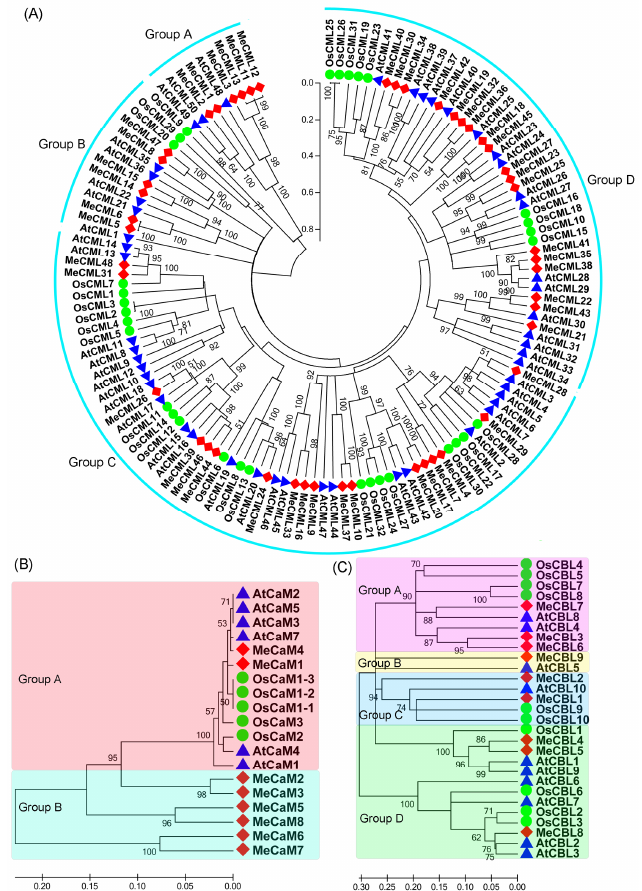
Figure 1. Phylogenetic analysis of calmodulin-like proteins (CMLs) ( A ), calmodulins (CaMs) ( B ), and calcineurin B-like proteins (CBLs) ( C ) from cassava, Arabidopsis , and rice. The Neighbor-joining (NJ) tree was constructed using Clustal X 2.0 and MEGA 5.0 software with the pair-wise deletion option. One thousand bootstrap replicates were used to assess tree reliability. Blue triangle, calcium (Ca 2+ ) sensors in Arabidopsis ; Red square, Ca 2+ sensors in cassava; Green circle, Ca 2+ sensors in rice. Shade areas with different colors indicate distinct groups of CaM and CBL families.